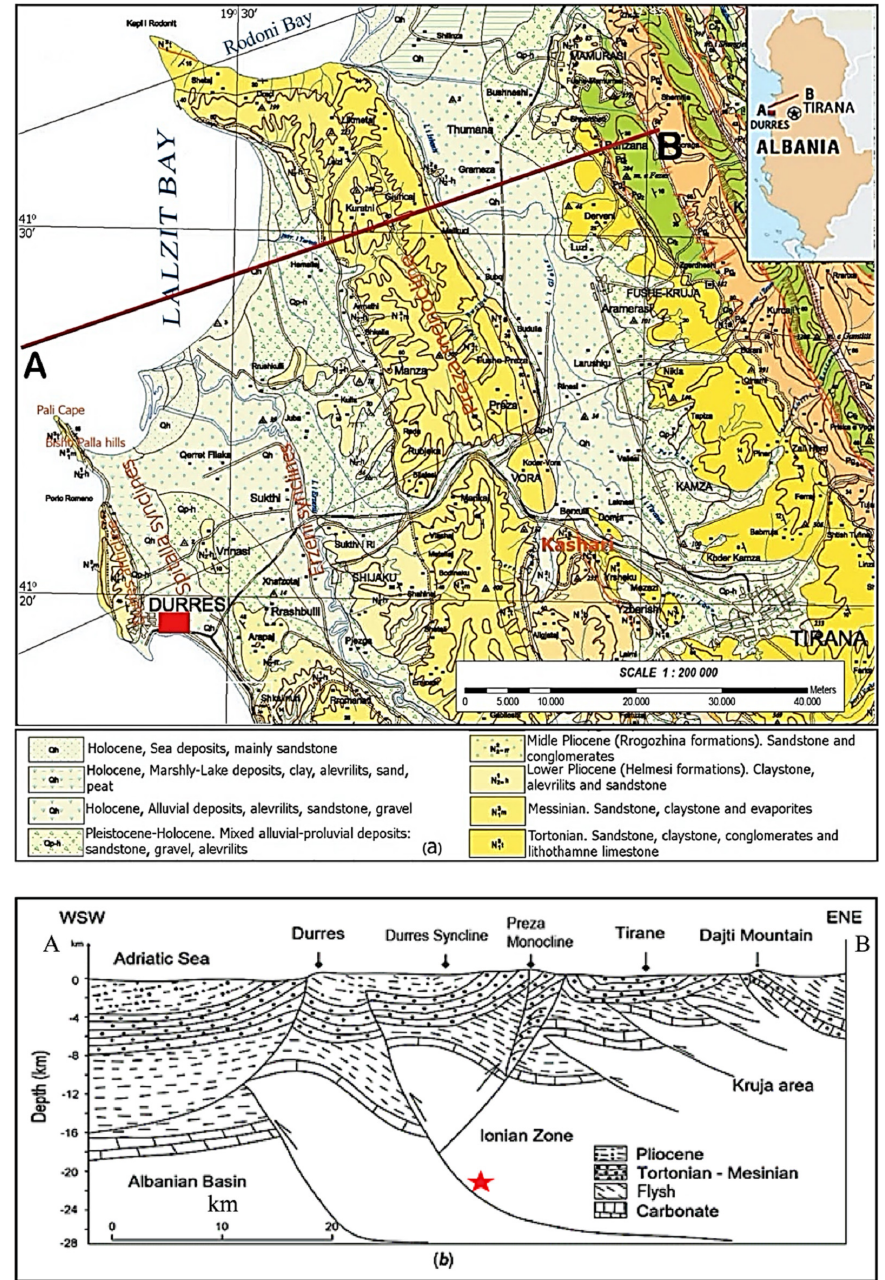
Figure 1. ( a ): Geological map of Durres (section from the Geological Map of Albania 1:200,000, from [29]); the profile trace line (A—B), oriented WSW—ENS, crosses the main geological units of Durres, through Porto Romano Bay; ( b ): Schematic geologic section, along the A—B profile, trending NE, from the Adriatic Sea to Kruja-Tirana region, [27]. The red star indicates the location the of 26 November 2019 mainshock’s hypocenter (M6.4)